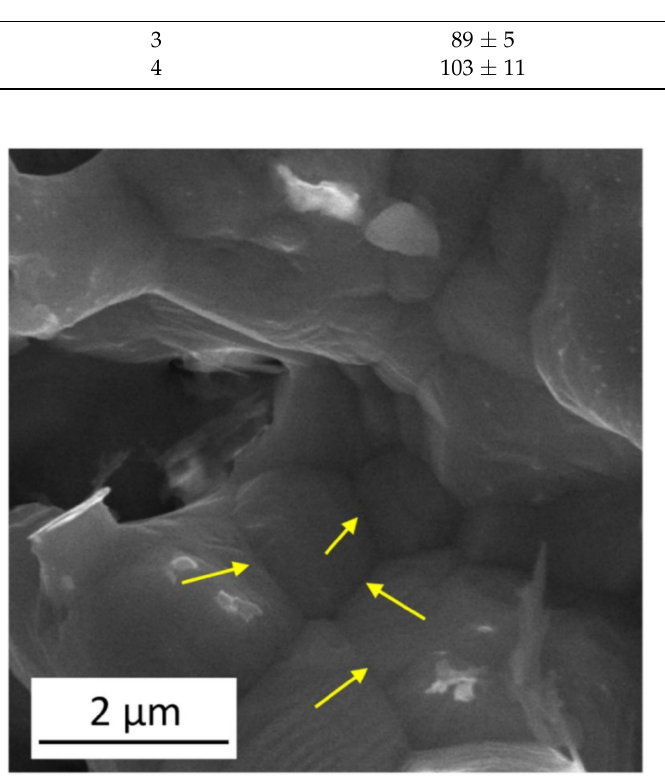
Figure 4. SEM image illustrates several ligaments grown in the material processed by route C and subsequently annealed at 800 ◦ C for 5 h. The yellow arrows indicate boundaries between the coalesced